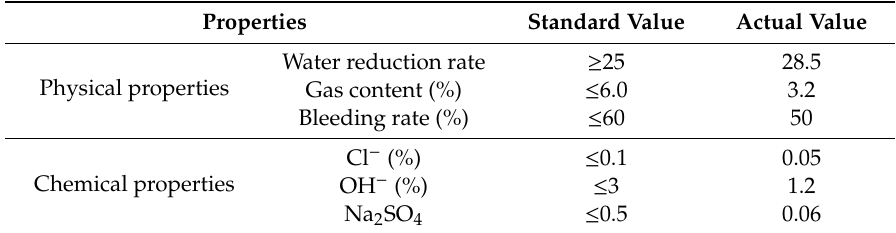
Table 4. Physical and chemical properties of superplasticizer.